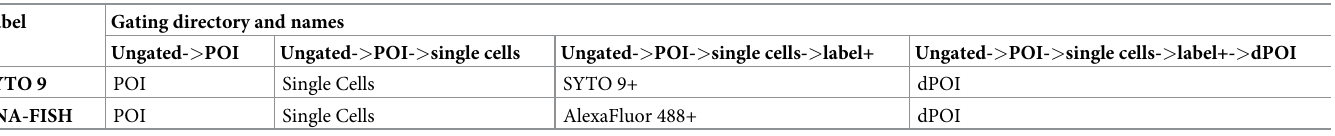
Table 2. Gating methods flow chart.